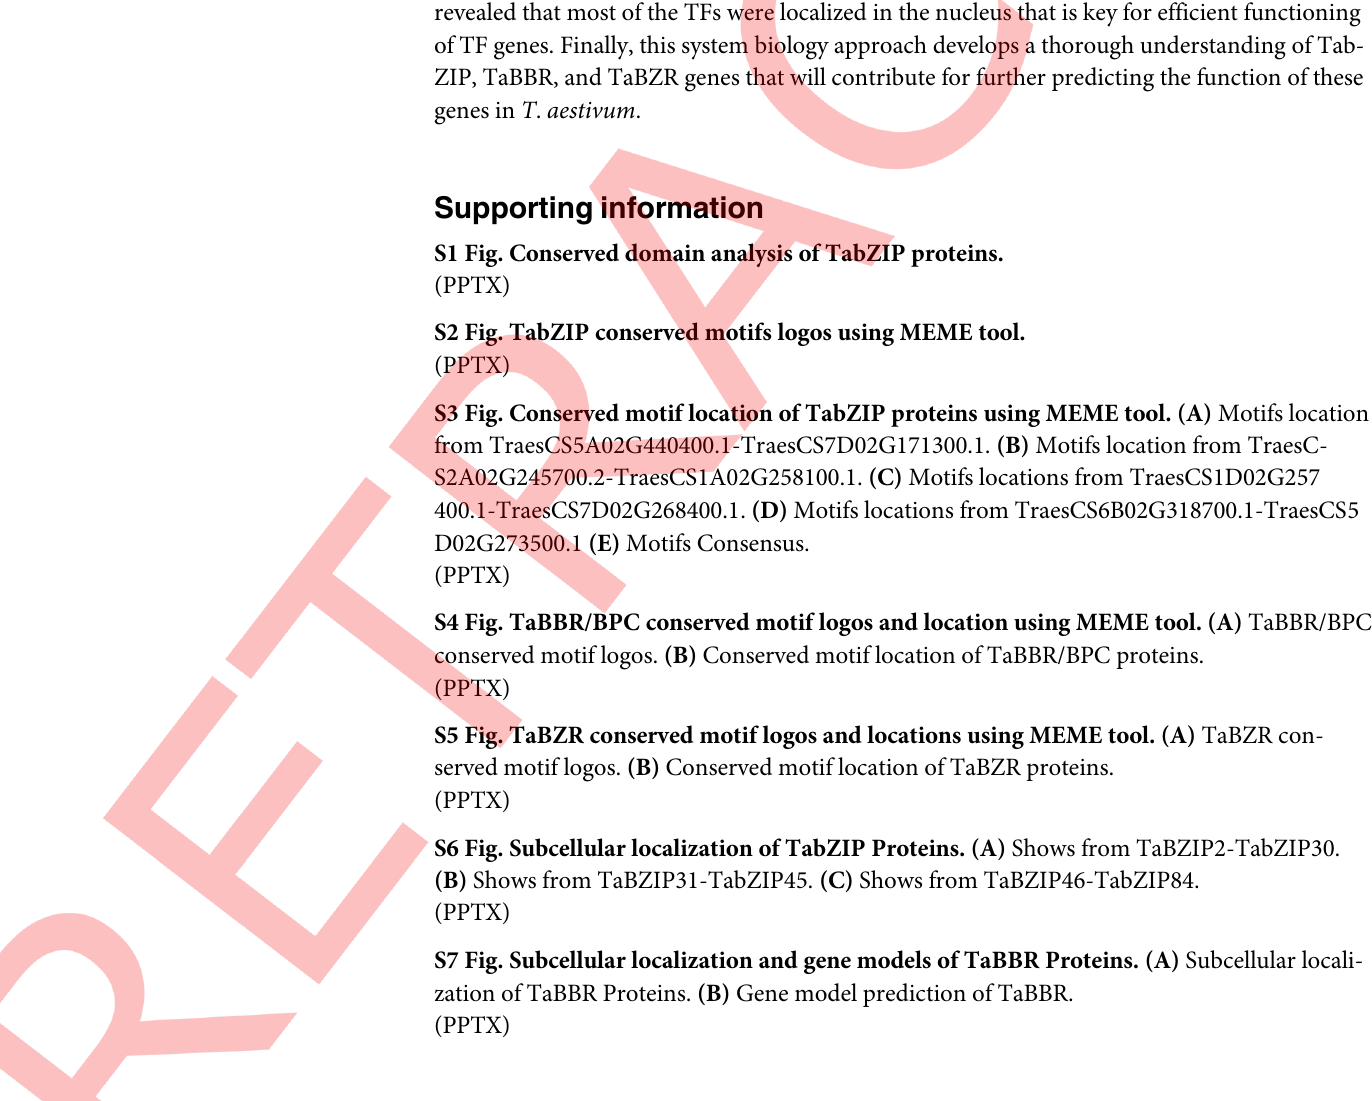
S1 Fig. Conserved domain analysis of TabZIP